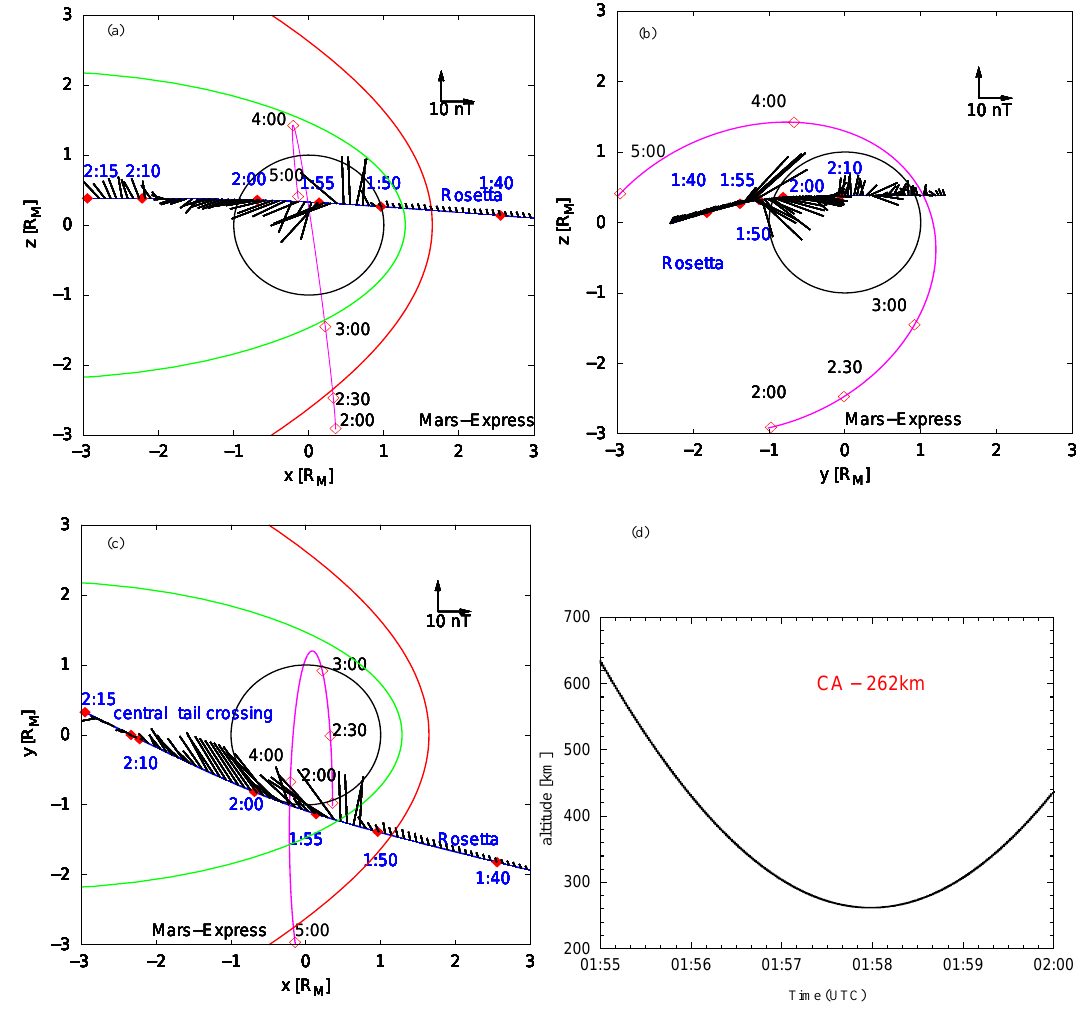
Fig. 1. (a–c) Projections of the trajectory of Rosetta (in blue) and MEX orbit in pink) on the MSO coordinate planes on 25 February 2007. The x-axis points toward the sun, the y-axis points in negative direction of the orbital motion and the z-axis complete the right hand system pointing to the north pole of the planet. Rosetta comes from the undisturbed solar wind regime on the dawn side of the planet and reached an altitude of 260km (CA) at around 05:00LT=01:58UT, still at the night side. Rosetta’s trajectory lays in the equatorial plane, shifted only slightly into the Northern Hemisphere. The orbital plane of MEX is tilted predominantly to the terminator (x-z plane). Additionally magnetic field measurements of ROMAP are presented along Rosetta’s trajectory. The average bow shock position by MGS is presented in red and the average MPB position in green (Vignes et al., 2000). (d) Altitude of Rosetta above the Martian surface during the passage of